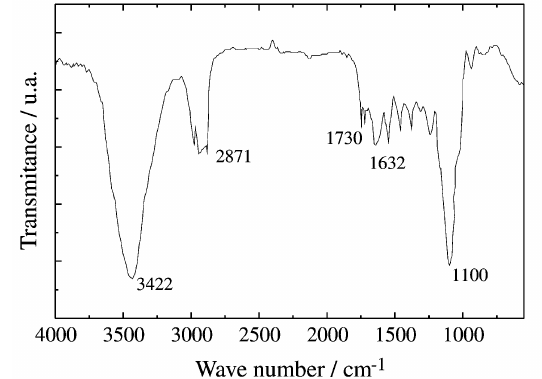
Figure 4. FTIR of the amylopectin-rich stanch grafted with toluene poly(propylene oxide) diisocyanate.